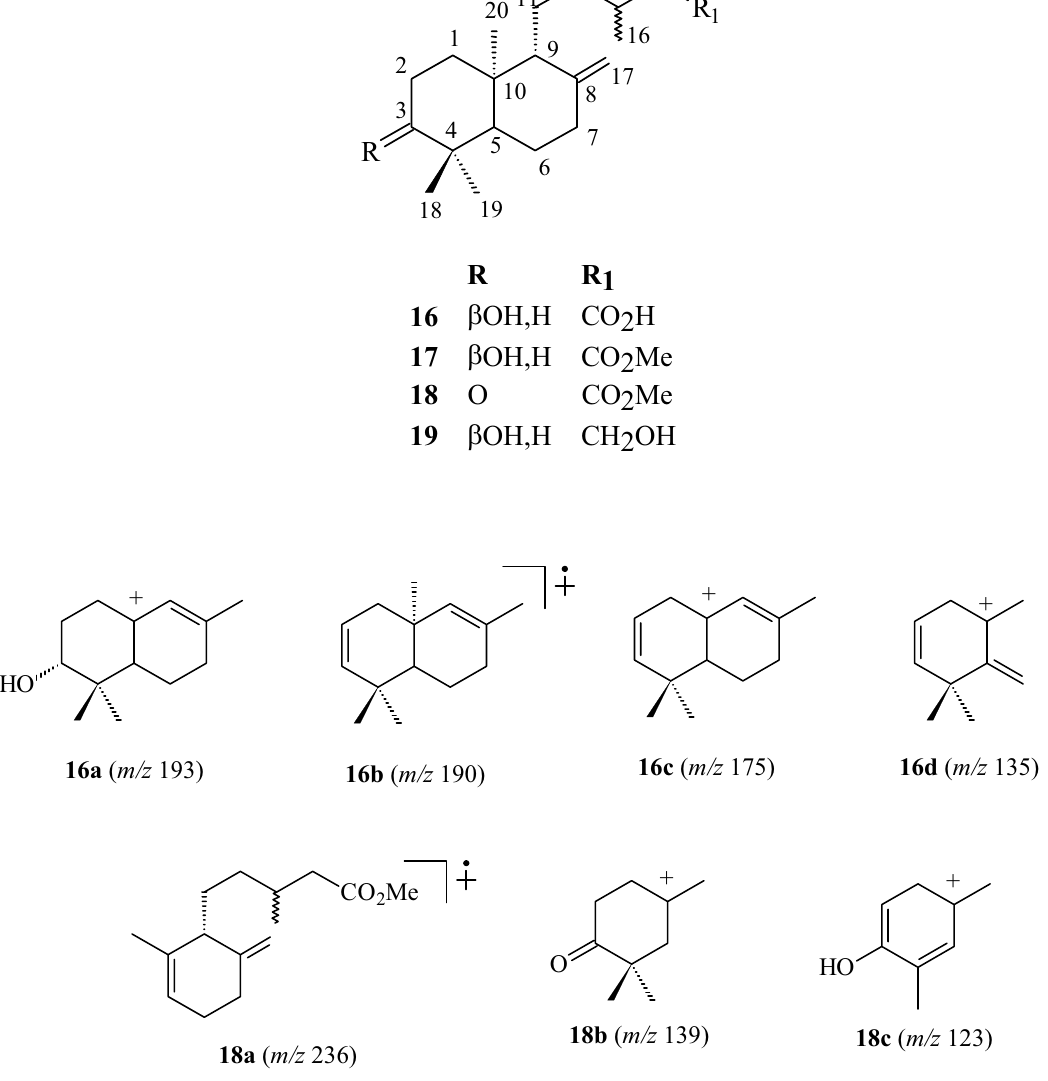
Fig. 5 – Structure of the labdane diterpenoid 16 , derivatives 17-19 (upper) and their ionic fragments corresponding to principal peaks observed in the mass spectra